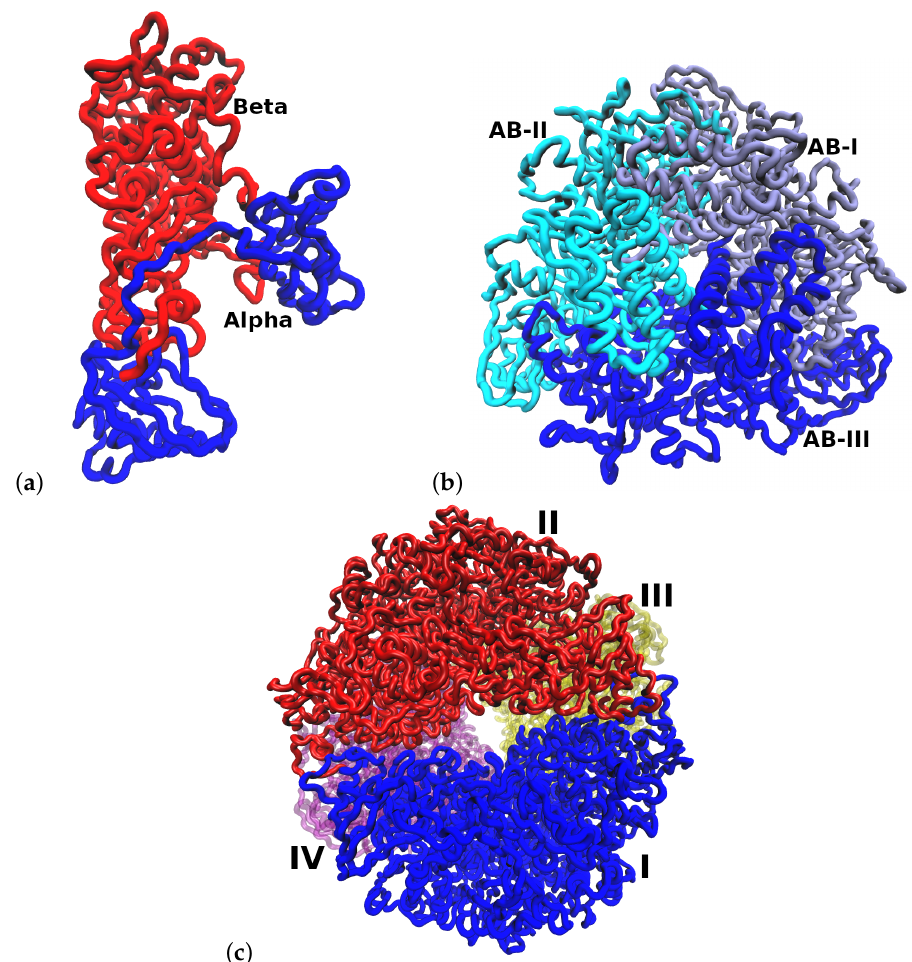
Figure 1. Structural arrangement of HP urease at pH 7.5. ( a ) Heterodimer ( αβ ). ( b ) Arrangement of one ( αβ ) 3 subunit. ( c ) Entire urease structure where each with I, II, III and